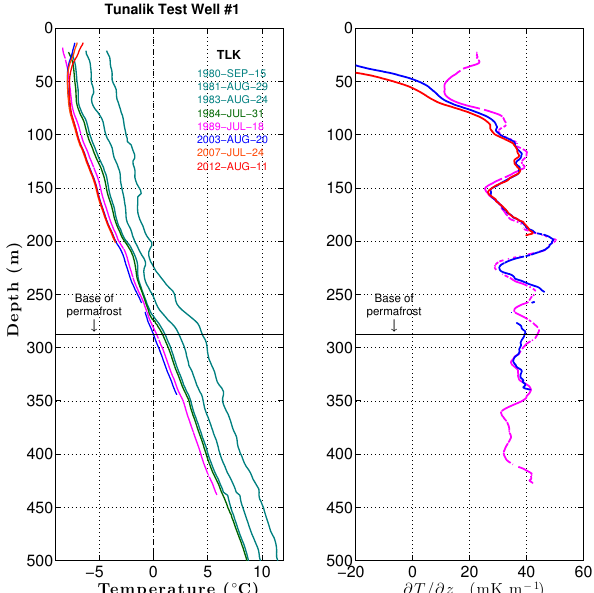
Figure 28. Temperature profiles in the Tunalik Test Well No. 1, color-coded by acquisition date (left). Temperature gradients calculated from the 1989, 2003, and 2012 logs are shown in the right panel.